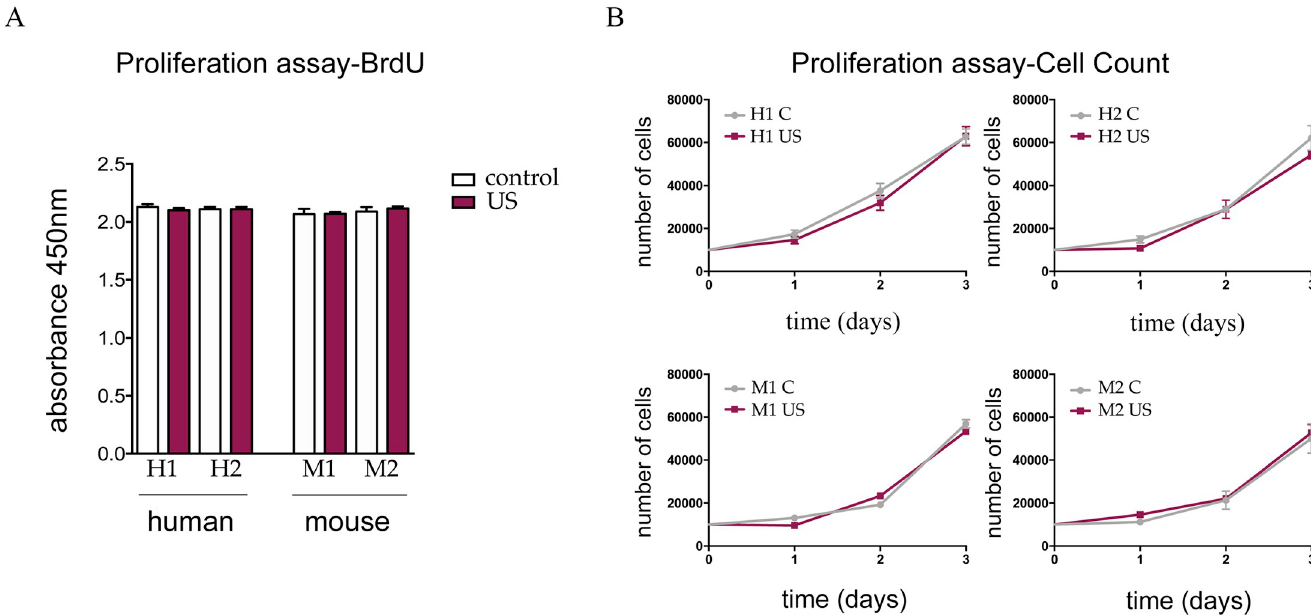
Fig 4. Application of LIPUS does not modify the proliferation capacity of s-MPs. (A) Cell proliferation was evaluated by BrdU incorporation. Data are shown from a representative experiment out of three performed and denote mean ± SD. No significant differences were found (Student’s t-test). (B) Cell proliferation was calculated by cell counting. Data are shown from a representative experiment out of three performed and denote mean ± SD. No significant differences were found (two-way ANOVA with Tukey’s multiple comparisons test). Shown are two independent samples of mouse (M1 and M2) and human (H1 and H2) s-MPs under control conditions or treated with ultrasound